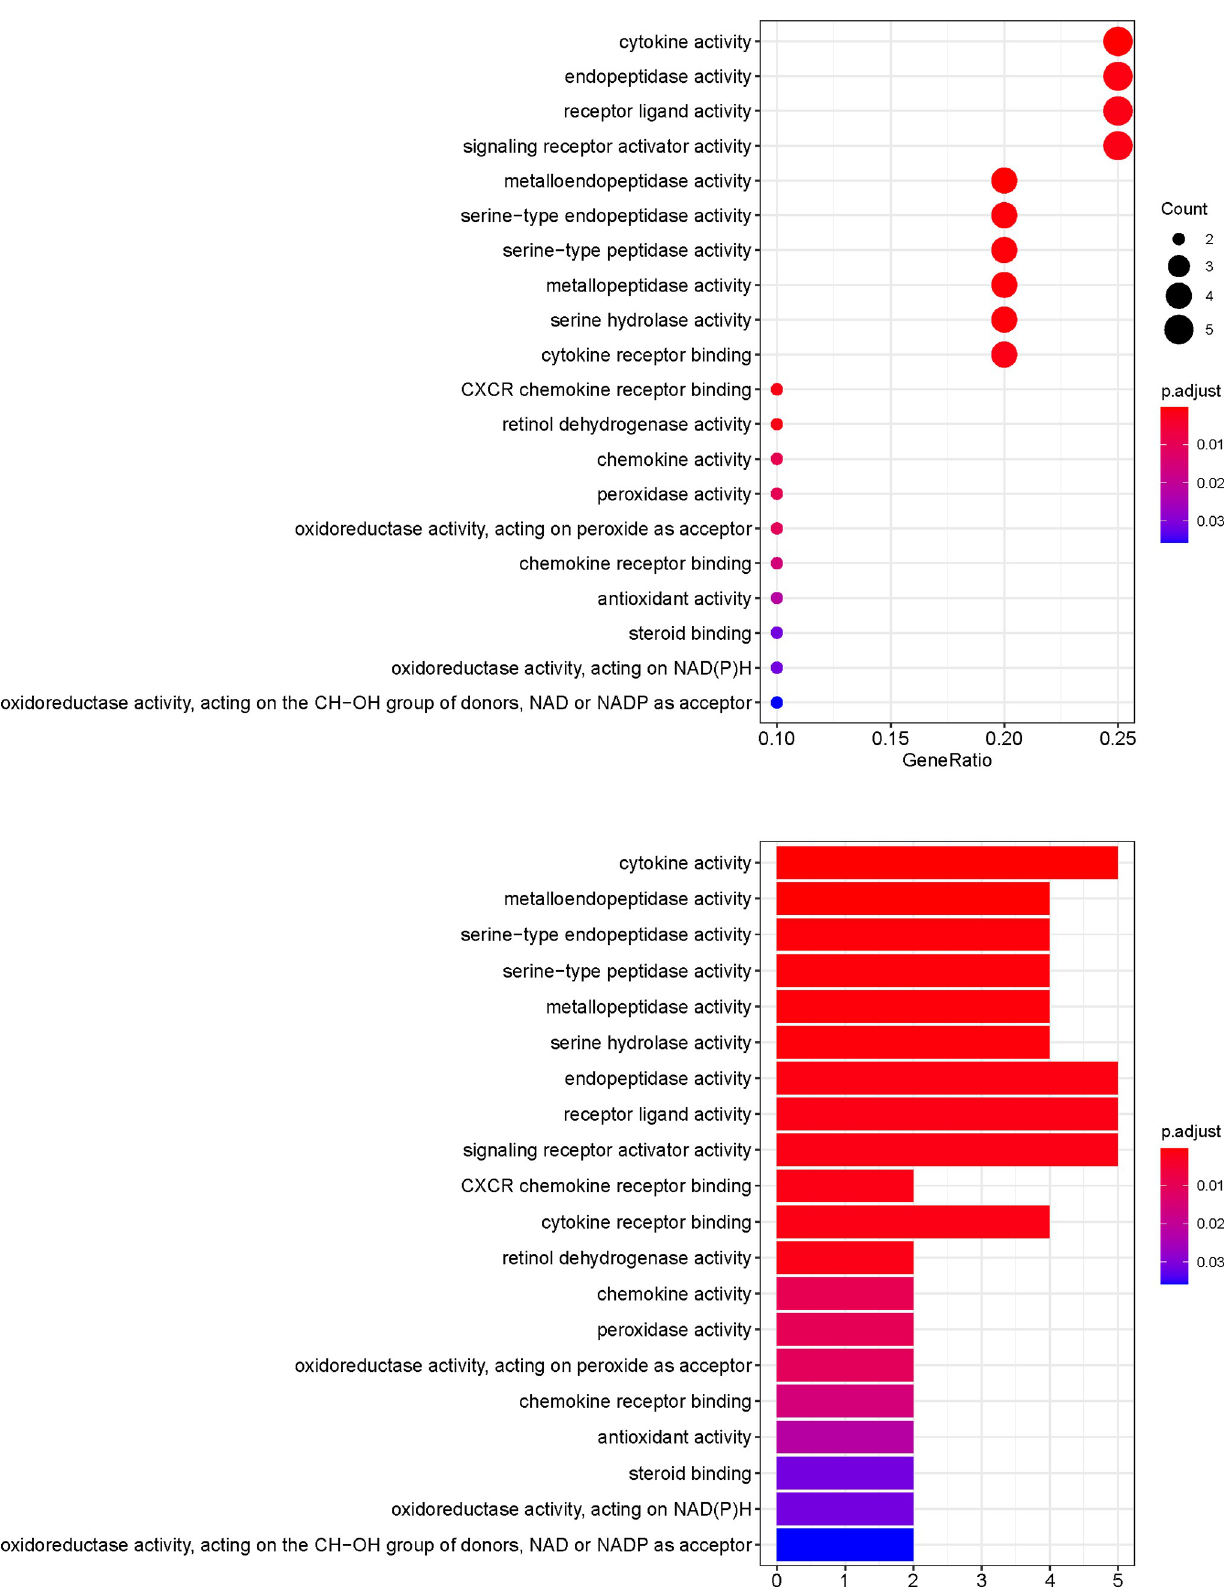
Fig 8. MF analysis of GO